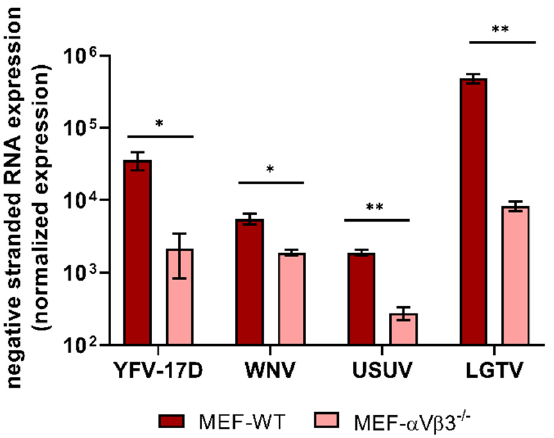
Figure 6. Relative quantification of flavivirus antigenome (negative-strand) RNA in MEF-WT and MEF- α V β 3 − / − cells. Cells were infected with YFV-17D, WNV, USUV and LGTV at a MOI of 10. After 48 h post inoculation, monolayers were washed, harvested, lysed and total RNA was extracted. RT-qPCR was performed to quantify the amount of negative-strand RNA. The levels of flavivirus negative-strand RNA were normalized against beta-actin, a housekeeping gene, and the relative gene expression was calculated by 2 ^- ΔΔ Ct method. Levels of flavivirus negative-strand RNA were expressed as fold amplification in relation to the housekeeping gene. Three independent experiments were performed in triplicate each. Bars represent mean values and error bars represent the standard deviation (mean ± standard deviation). Statistical analysis: Unpaired Student’s t-test with Welch’s correction: (*) = p ≤ 0.05 and (**) = p ≤ 0.01.